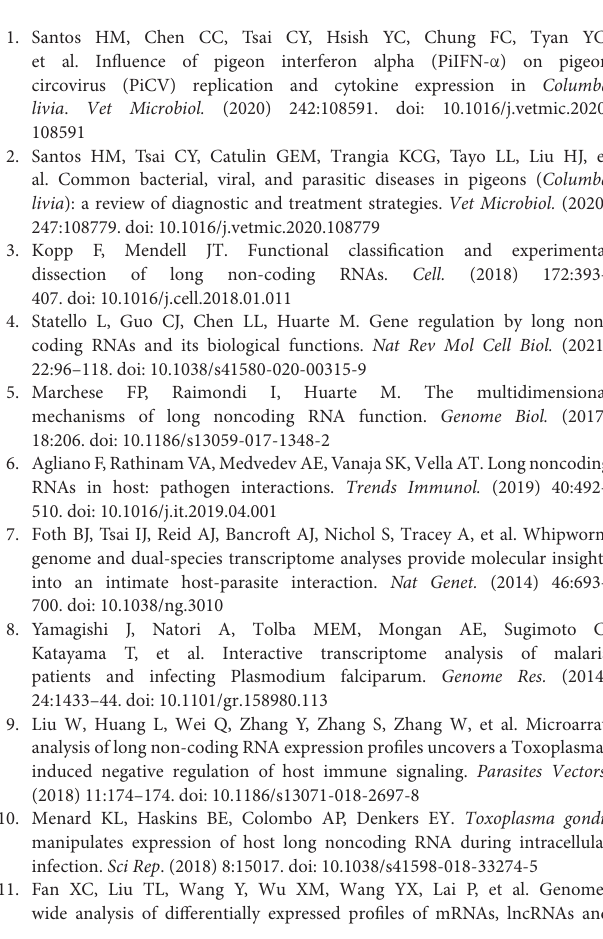
Supplementary Table 1 | Genomic locations and types of predicted lncRNA. Supplementary Table 2 | Significantly differentially expressed (DE) lncRNAs and DE genes among control (N), susceptible (S), and tolerant (T) pigeons. DE-lncRNA (a) and DE genes (b) within N vs. S; DE-lncRNA (c) and DE genes (d) within N vs. T; DE-lncRNA (e) and DE genes (f) within S vs. T. Supplementary Table 3 | The cis/trans target genes of differential expressed (DE) lncRNA among control (N), susceptible (S), and tolerant (T) pigeons. The protein-coding genes within 100k upstream and downstream of DE-lncRNA with in N vs. S birds (a) , with in N vs. T birds (c) and with in S vs. T birds (e) . The Supplementary Table 4 | Significant gene ontology (GO) terms for cis/trans target genes of DE-lncRNAs. Supplementary Table 5 | Co-expressed pairs of differentially expressed (DE) lncRNA and DE genes within control vs. susceptible birds (a) , control vs. tolerant birds (b) , and susceptible vs. tolerant birds (c)